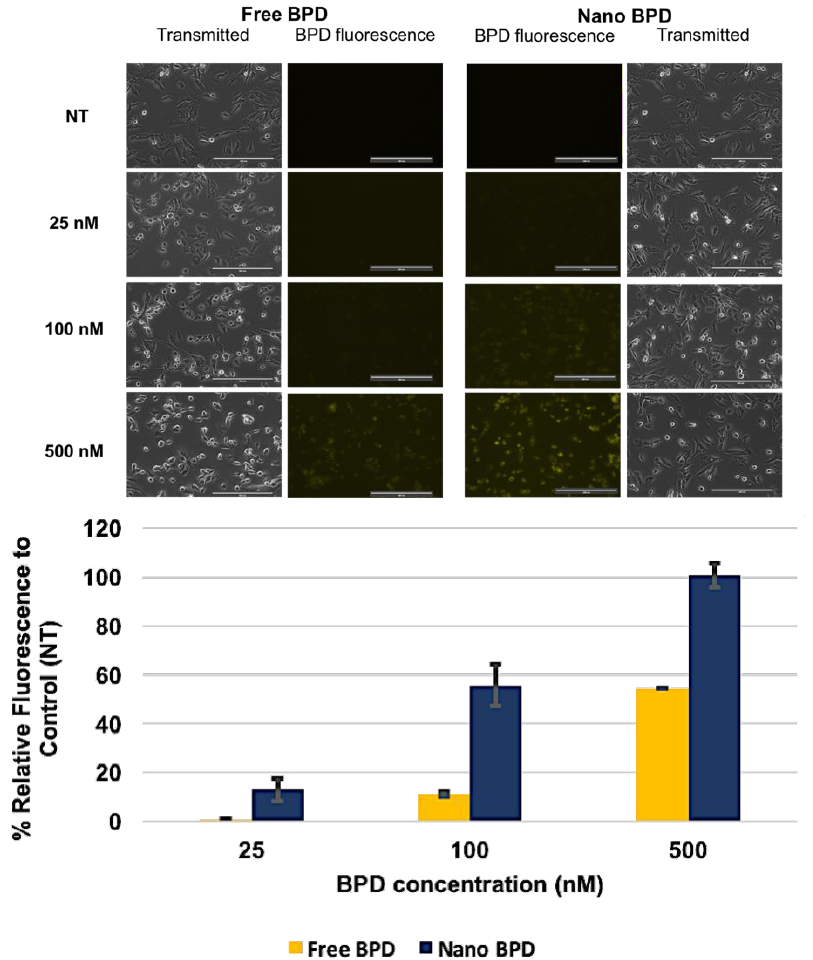
Figure 5. Imaging study results for free versus NP formulations of BPD using various concentrations of 25, 100, and 500 nM BPD to assess fluorescence in U87 cells. Images were taken at 20× magnification at 60% light intensity (Cy5 filter) for each image shown above. An increase in fluorescence is seen in the NP BPD form compared to the free drug, as shown in the bar graph for % fluorescent intensity relative to the control, no treatment (NT). Results are represented as mean ± standard deviation for n = 2. Scale Bar: 200 µm.